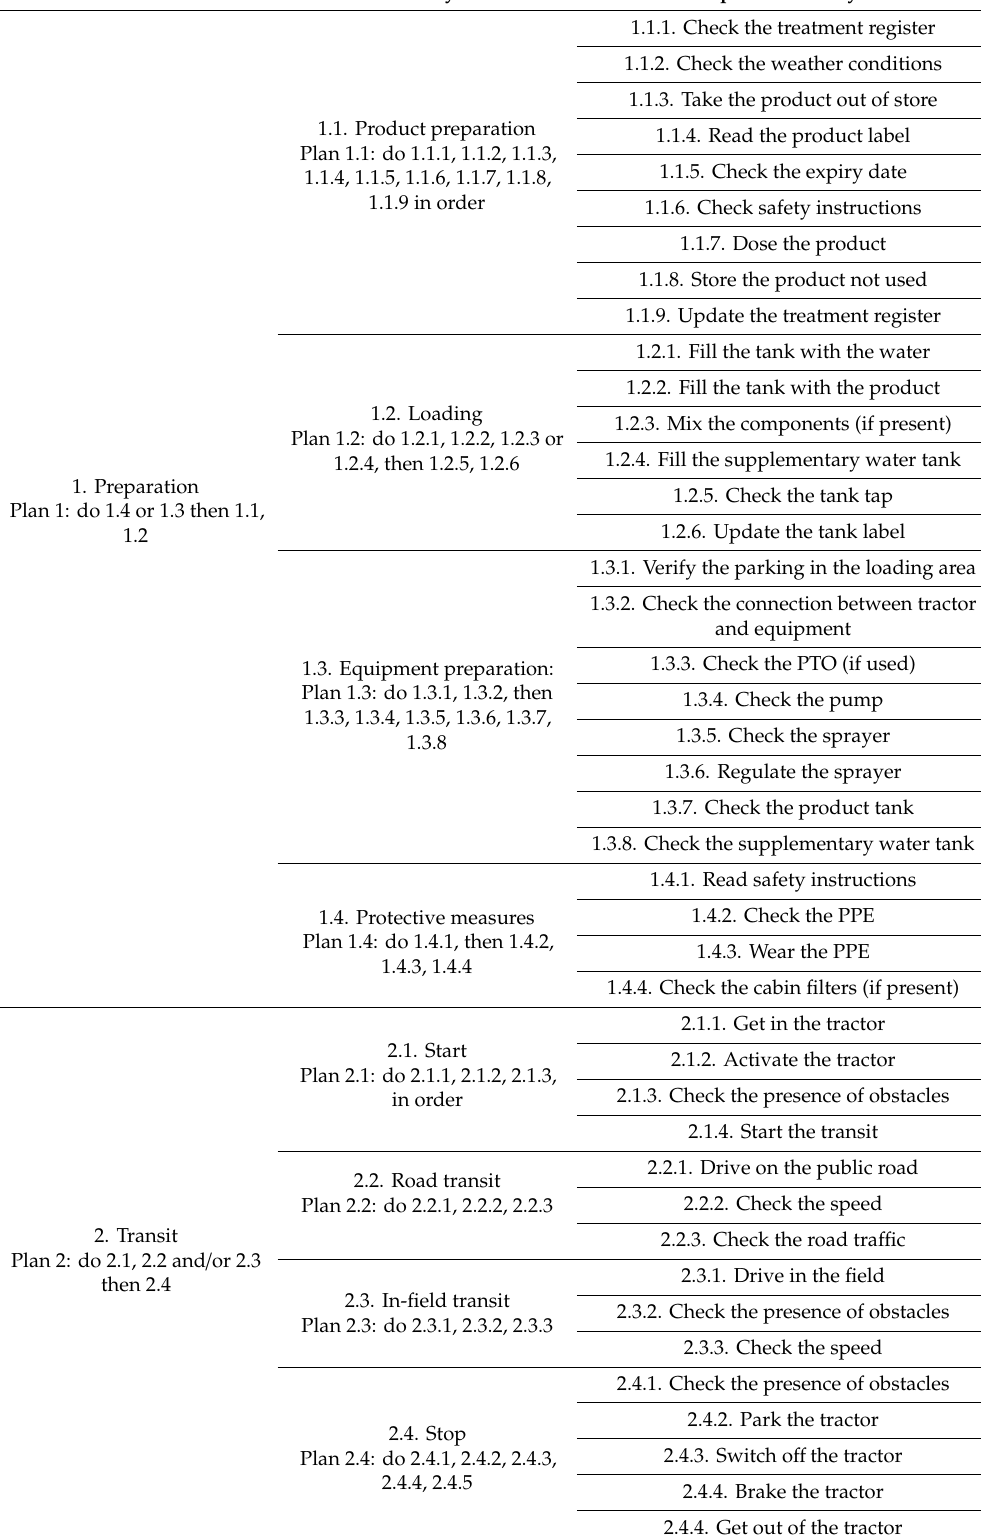
Table A1. List of sub-tasks, elementary tasks and specific activities.